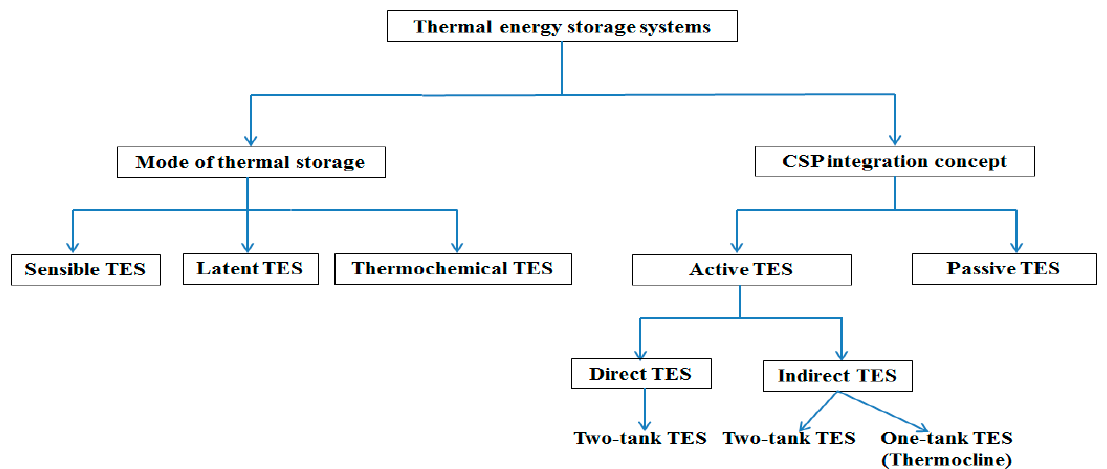
Figure 15. Classification of thermal energy storage systems for CSP applications.